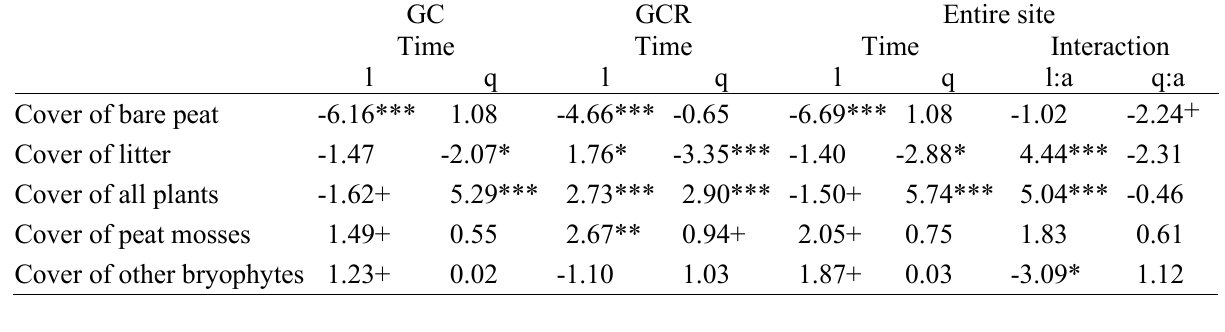
Table 1. Trends in the cover (%) of variables describing the plot structure in the two areas (GC and GCR) and the entire site. Results of separate regression models for the GC-area and GCR-area, as well as results from the combined model, are shown. Numbers are th e effect sizes of the orthogonal polynomials of time and their interaction with area type. GC = grazing cessation; GCR = grazing cessation and rewetting; l = linear term; q = quadratic term; l:a = interaction linear term between time and area type; q:a = interaction quadratic term between time and area type; Significance levels: +: p ≤ 0.1; *: p ≤ 0.05; **: p ≤ 0.01; ***: p ≤ 0.001.